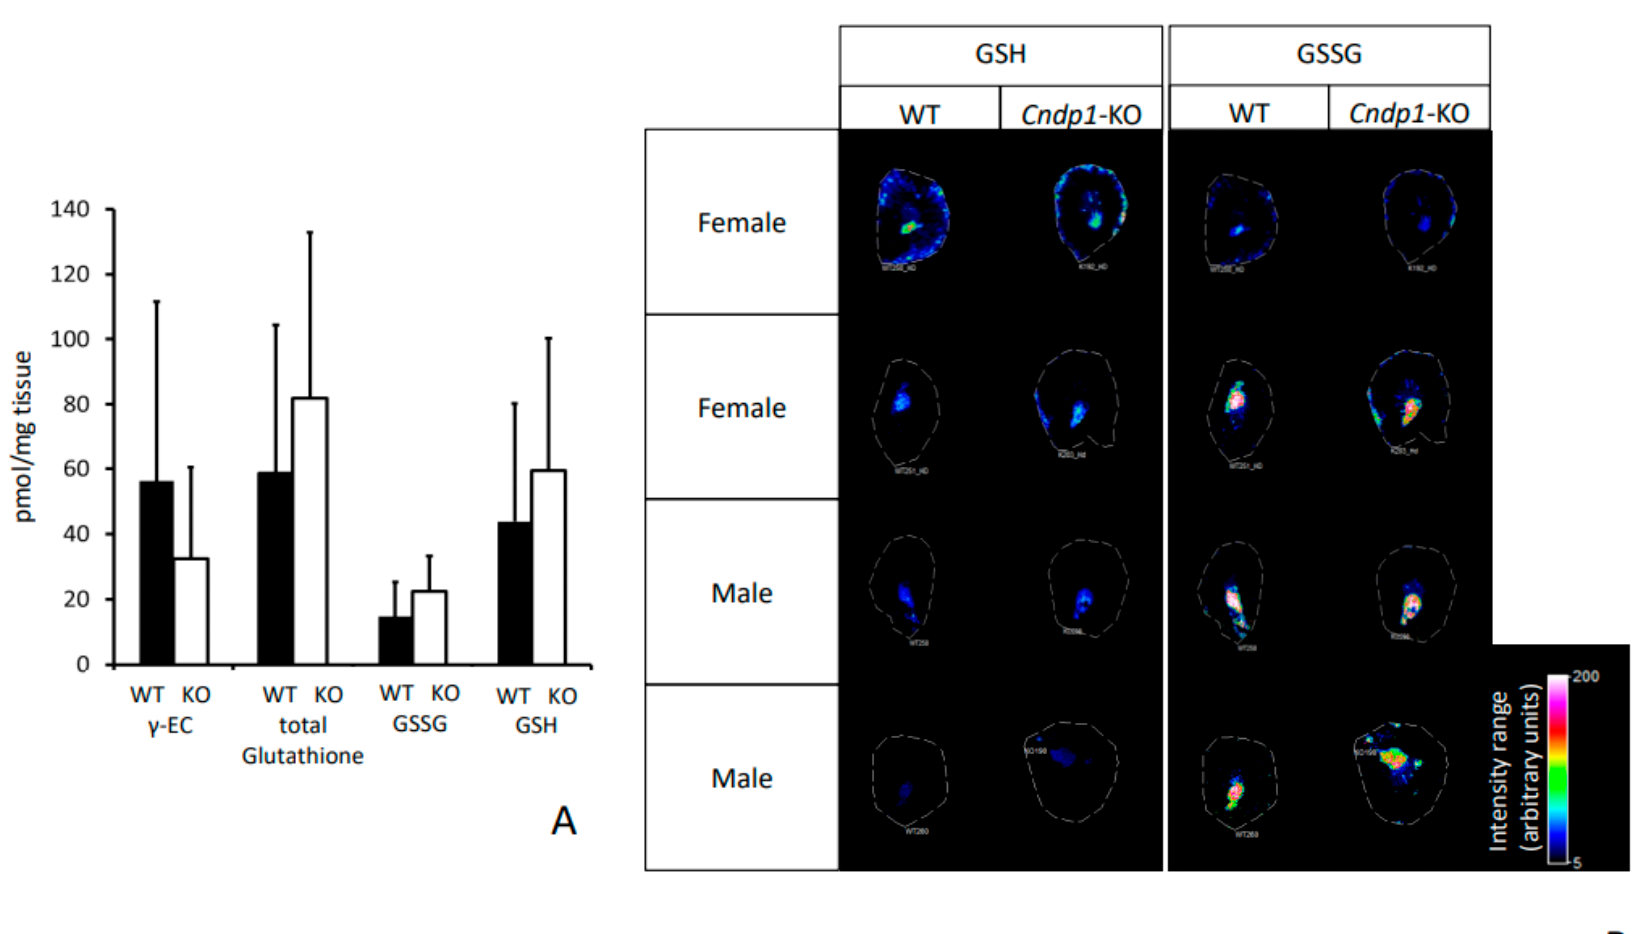
Figure 5. Renal glutathione (GSH) and glutathione disulfide (GSSG) concentrations and ratios were in the same range for 55-week-old Cndp1 -KO ( n = 14) and WT mice ( n = 14) measured by (UPLC-FLR ( A ) and visualized by MALDI-MSI ( B ). No difference in the glutathione precursor dipeptide γ -glutamylcystein ( γ -EC) was detected ( A ).